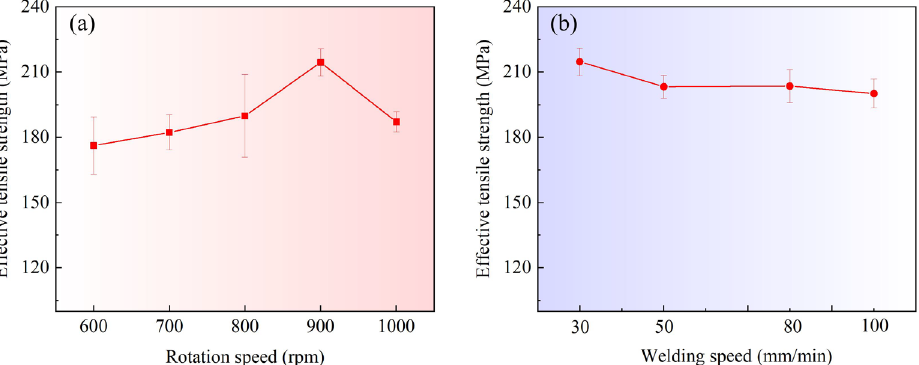
Figure 15. Fracture locations at various rotation speeds and welding speeds: ( a – e ) v = 30 mm/min; ( f – h ) ω = 900 rpm; ( a ) ω = 600 rpm; ( b ) ω = 700 rpm; ( c ) ω = 800 rpm; ( d ) ω = 900 rpm; ( e ) ω = 1000 rpm; ( f ) v = 50 mm/min; ( g ) v = 80 mm/min; ( h ) v = 100 mm/min; ( d = 12 mm).